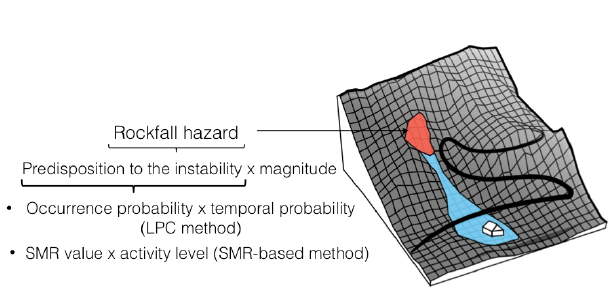
Table 4. Qualitative scale of the predisposition to instability. Very High The fall of the rock mass will happen imminently. High The fall of the rock mass is more probable than its stability. The temporal probability estimate is approximately 2 years. Moderate The probability of the fall of the rock mass is equivalent to its stability. The temporal probability estimate is approximately 10 years. Low The stability of the rock mass is more probable than its fall. The temporal probability estimate is approximately 30-50 years. Very Low